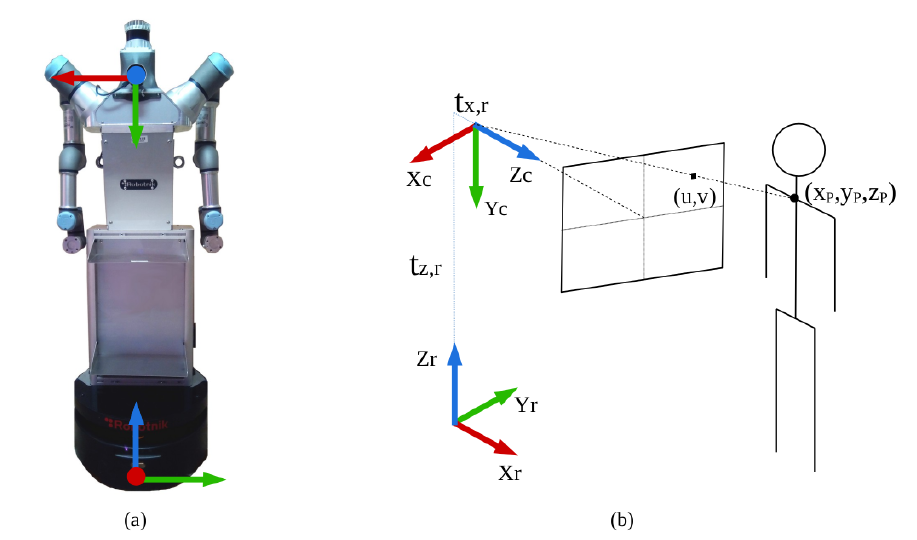
Figure 10. System reference frames: ( a ) camera (top) and base (bottom) frames placed on the robot, ( b ) camera frame (Xc,Yc,Zc) and base frame (Xr,Yr,Zr), where t x , r and t z , r indicate translations. The line joining the camera origin and the pixel (u,v) is defined by projectPixelTo3dRay , and cKDTree finds the 3D point